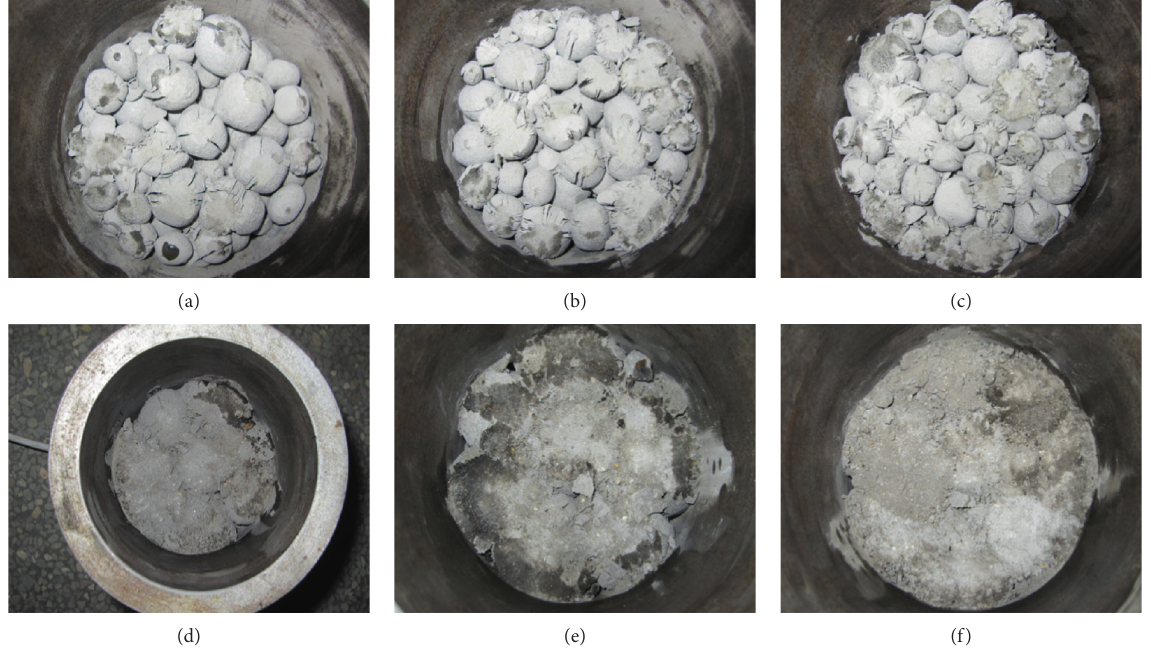
Figure 9: The breakage of particles under the loading of 30, 40, and 50kN: (a–c) cement particles; (d–f) cement mortar particles.